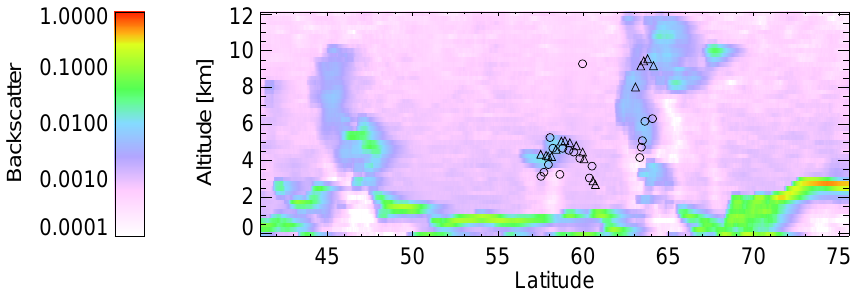
Figure 8. The results for an overpass of Eyjafjallajökull on 6 May 2010. The derived CALIOP cloud top heights (triangles) and the retrieved IASI plume top altitude (circles) are overplotted onto the CALIOP backscatter.